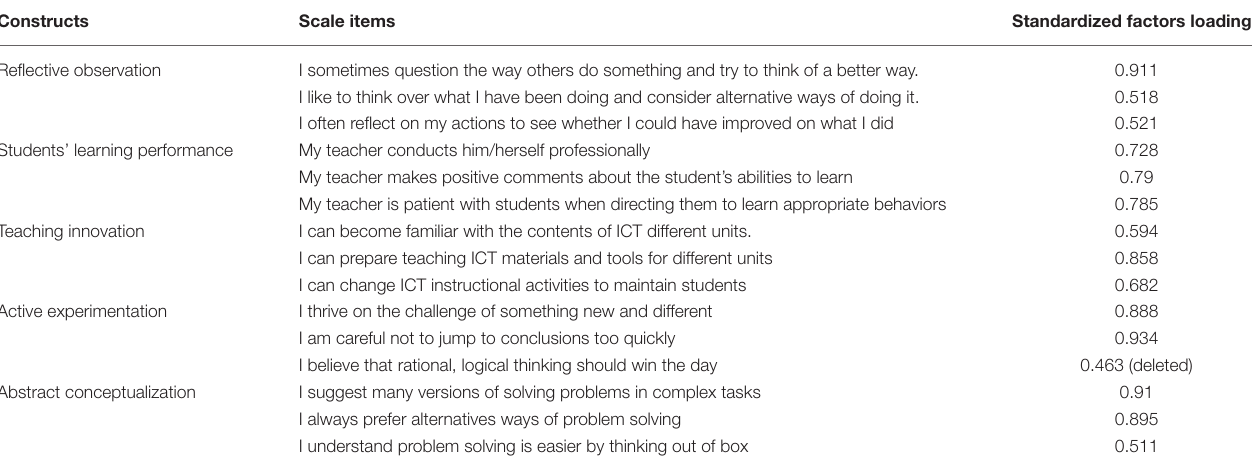
TABLE 1 | Results of confirmatory factor analysis.